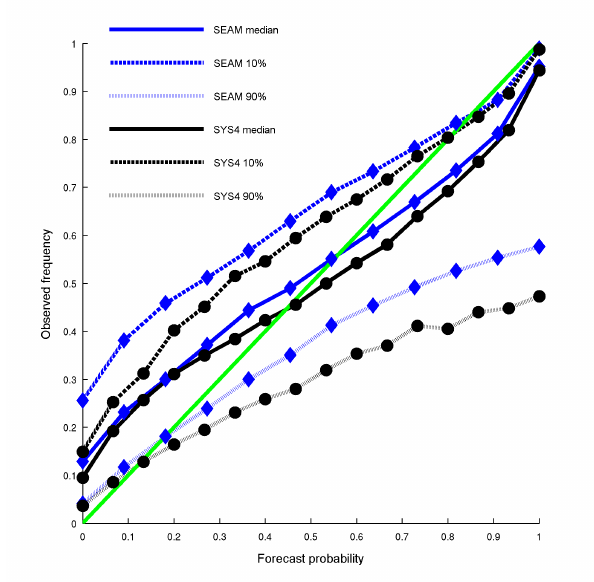
Figure 7. Reliability diagram for SEAM (blue) and SYS4 (black) for week 4 for all outlet points. Solid lines indicate the reliability for the median of observed discharge, the dashed (dotted) lines the forecast reliability for the 10th (90th) percentiles of observed dis-